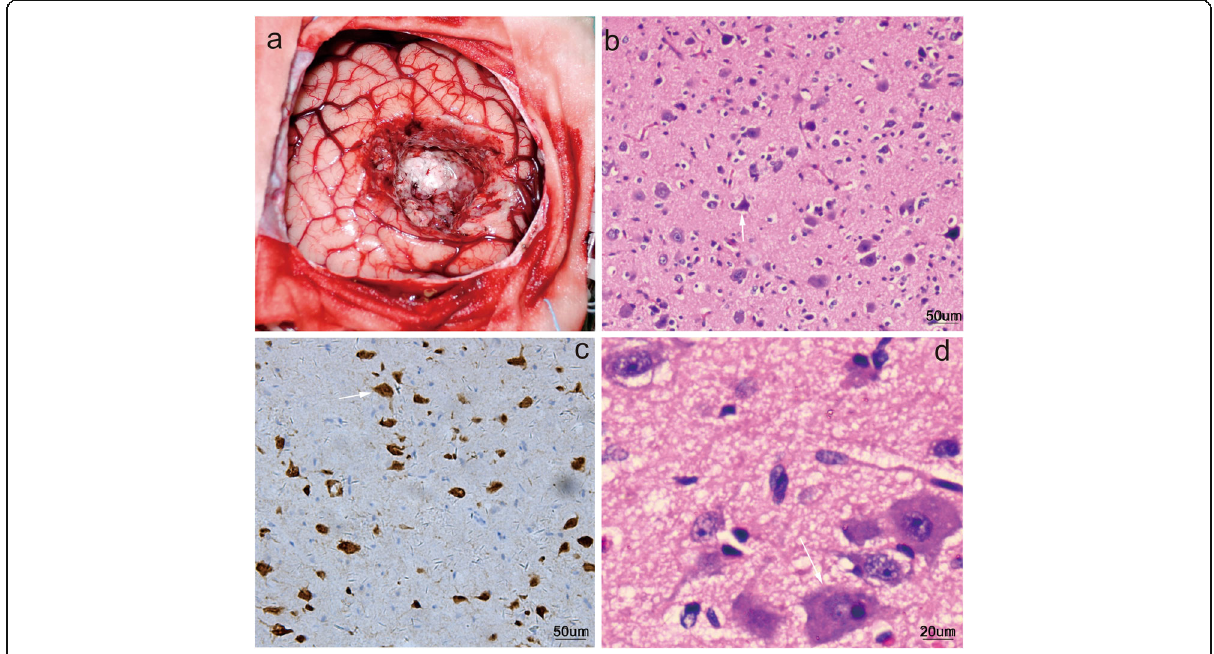
Fig. 2 Pathological examination in case 1. a Resection site. b HE staining of the resected tissue (× 200). c Immunohistochemical staining of NeuN (× 200). d HE staining (× 400). The pathological evaluation revealed abnormal structure and morphology of neurons, including spindle-shaped neurons, small- and medium-sized neurons and immature neurons (white